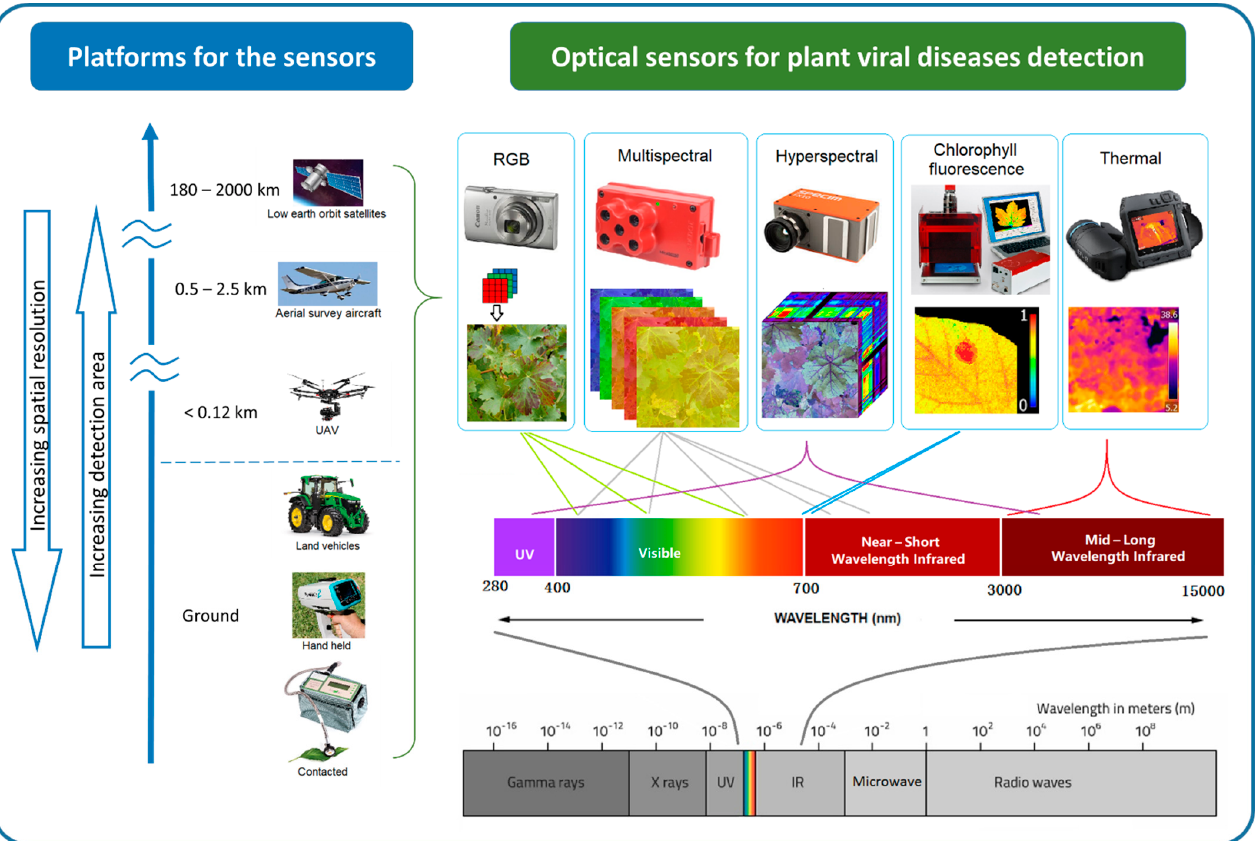
Figure 2. Optical sensing technologies for plant viral disease detection can be classified by their platform and associated spatial resolution and extent. Sensors also vary by band position, the spectral range within the whole electromagnetic spectrum.